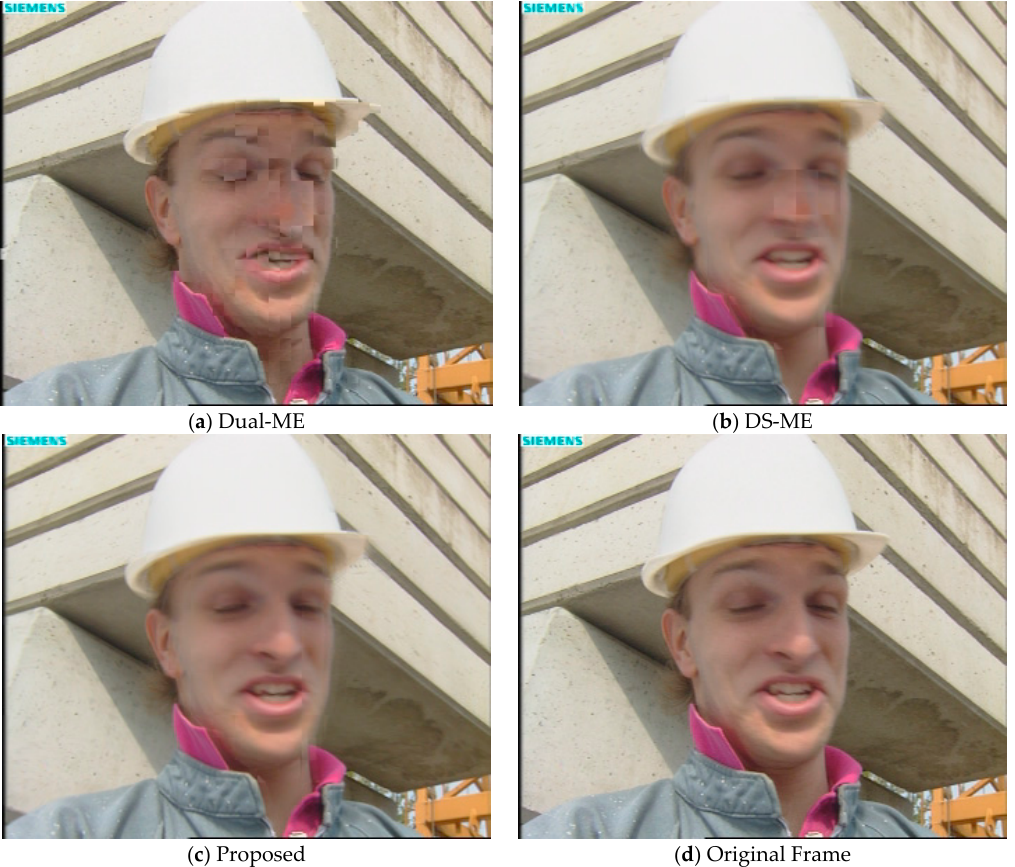
Figure 4. A visual comparison of the Foreman sequence between the three methods.